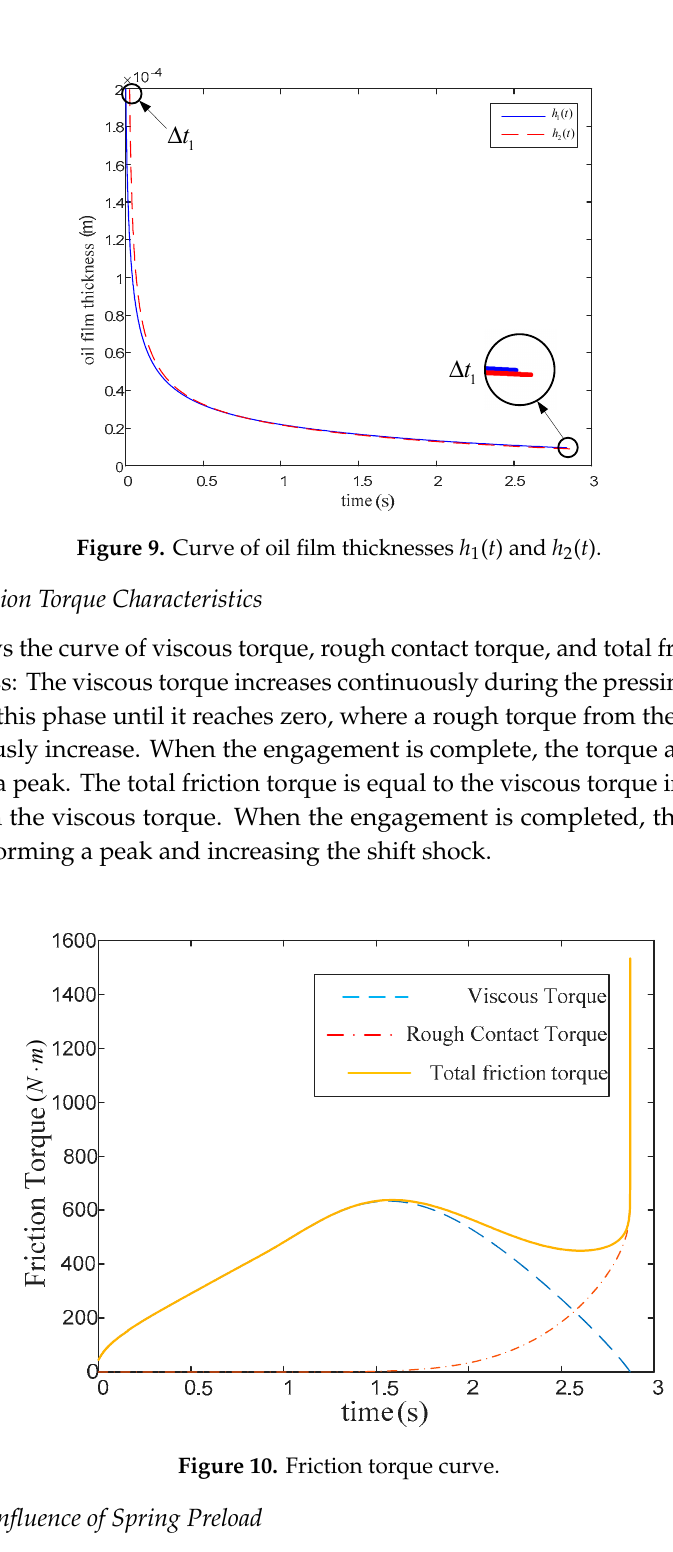
Figure 9. Curve of oil film thicknesses h 1 ( t ) and h 2 ( t ).